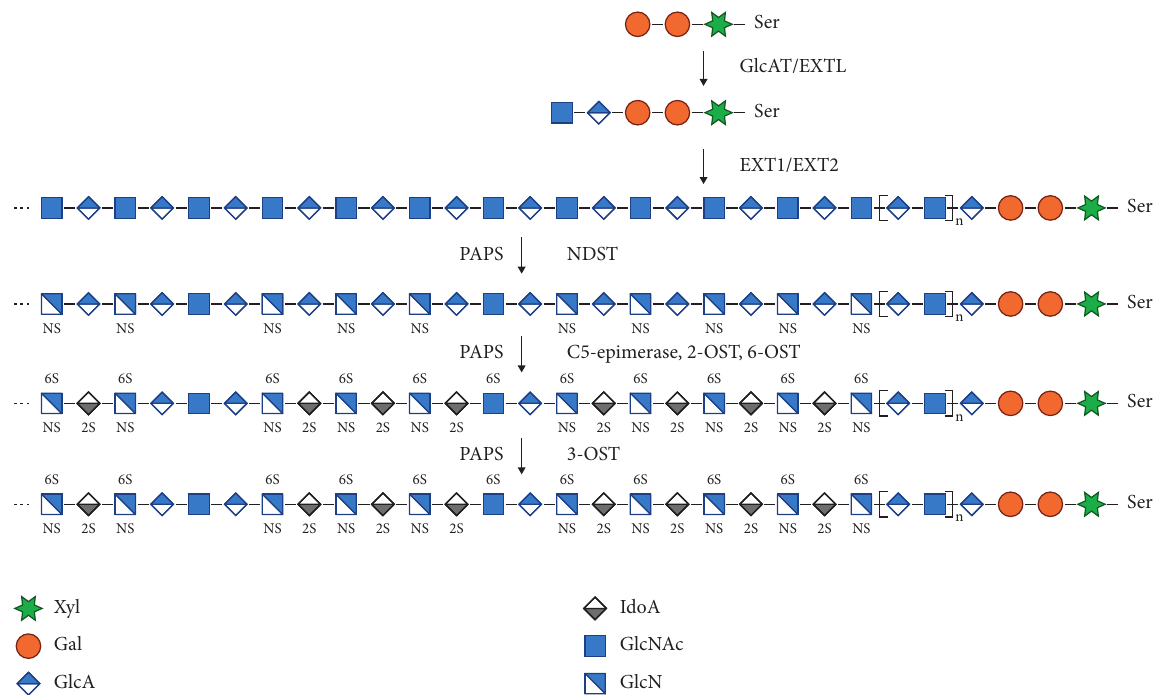
Figure 1: Biosynthesis of heparin/unfractionated heparin (UH). Xyl, xylose; Gal, galactose; GlcAT, glucuronosyltransferase; EXTL, initial N-acetyl glucosaminyl transferase; NDST, N-deacetylase/N-sulfotransferase isoforms; PAPS, 3’-phosphoadenosine-5’-phosphosulfate; NS, N-sulfated GlcN; 2S, 2-O-sulfated IdoA; 3S, 3-O-sulfated GlcNS; 6S, 6-O-sulfated GlcNS; n � 1 or